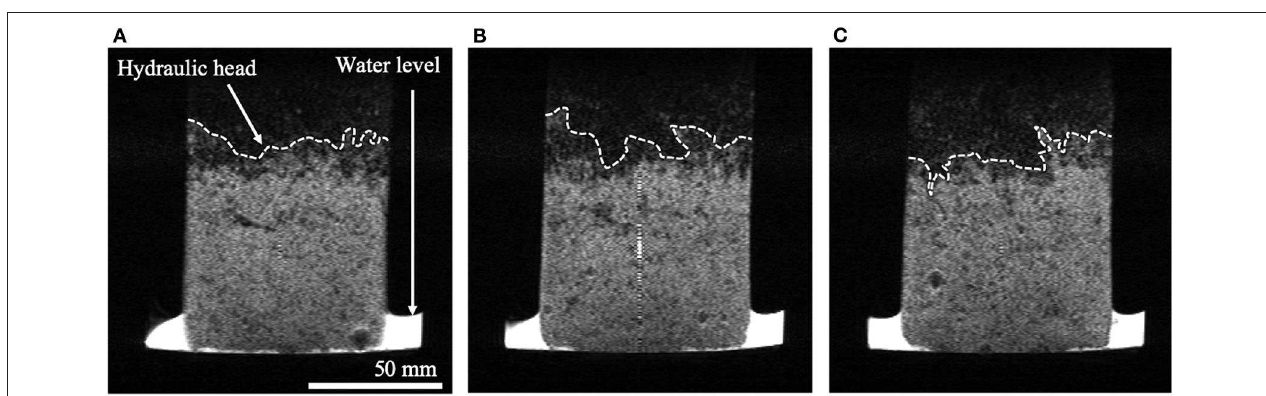
FIGURE 2 | Vertical images of MRI of wet snow sample. White area: water, Gray area: snow with a lot of water, Black area: low moisture snow or air gap. Broken lines are hydraulic head. (A) Image at 7th slice, (B) image at 8th slice, and (C) image at 9th